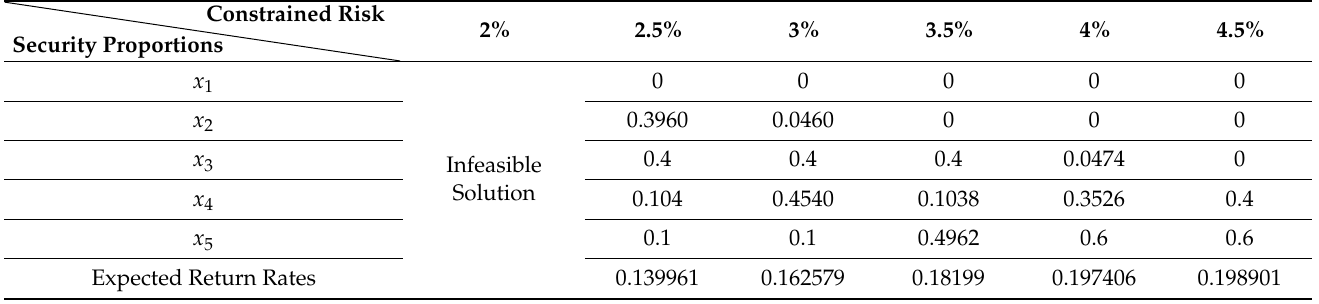
Table 17. The dimension with t = 3 and s = 5 with a guaranteed return rate (cid:101) p 2 in the proposed model.